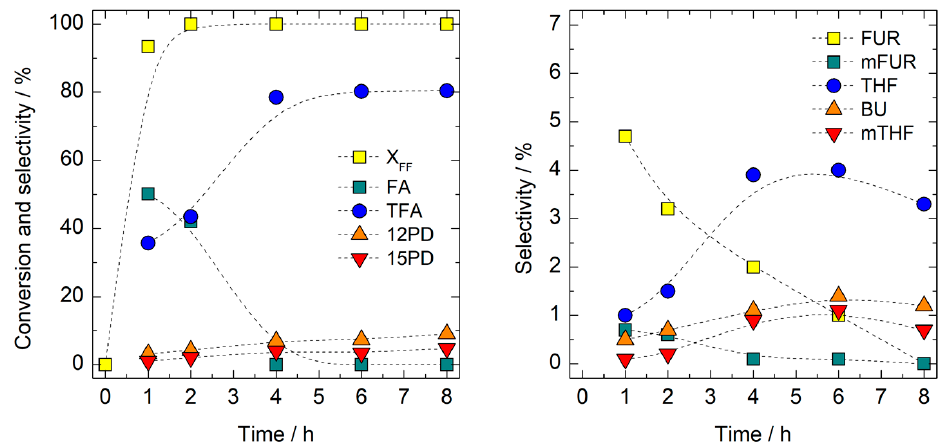
Figure 9. Furfural conversion and product selectivity over Ni 2 Mg 1 Al-R: effect of reaction time at 50 bar of H 2 and 190 ◦ C using 5 wt.% FF in ethanol (the dashed lines only indicate trends). The effect of temperature was tested at 160, 190 and 210 ◦ C, with the Ni 2 Mg 1 Al-R catalyst at 50 bar and 2 h. FF conversion was 92.7% at 160 ◦ C, and it was complete at higher temperature (Figure 10). Temperature favored the decarbonylation of FF to FUR, which grew from 1.5% at 160 ◦ C to 7.4% at 210 ◦ C, even if FA was always the main primary product (51.5% and 54.3% at 160 ◦ C and 210 ◦ C, respectively). Similarly, the